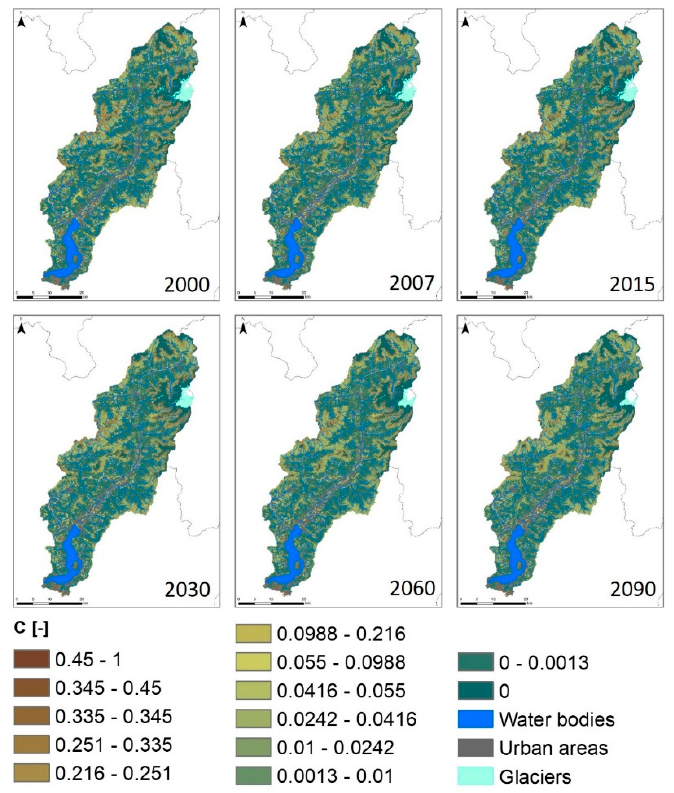
Figure 11. DUSAF based C-factor at 2000, at 2007, and at 2015 (first row) and LC based C-factor at 2030, at 2060, and at 2090 (second